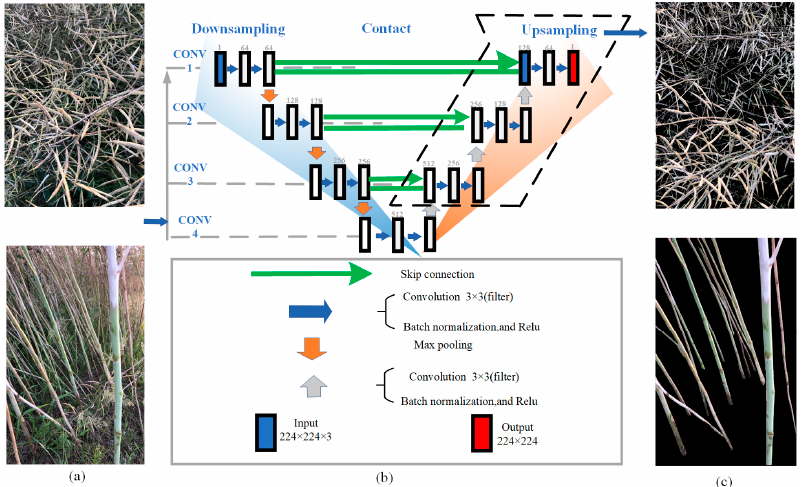
Figure 2. U-Net of rapeseed canopy and stalk images. ( a ) Original images of rapeseed canopy and stalk; ( b ) The chart above is the structure of U-Net, the chart below is explanations for the Contact; ( c ) Segmentation results with the